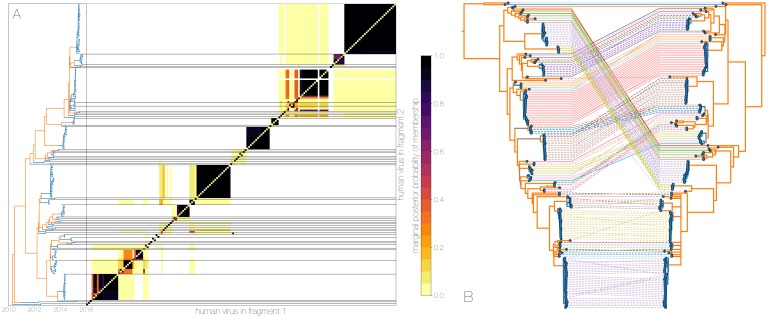
Recombinant features of MERS-CoV phylogenies.(A) Marginal posterior probabilities of taxa collected from humans belonging to the same clade in phylogenies derived from different parts of the genome. Taxa are ordered according to phylogeny of fragment 2 (genome positions 21001 to 29364) reduced to just the human tips and is displayed on the left. Human clusters are largely well-supported as monophyletic and consistent across trees of both genomic fragments. (B) Tanglegram connecting the same taxa between a phylogeny derived from fragment 1 (left, genome positions 1 to 21000) and fragment 2 (right, genome positions 21001 to 29364), reduced to just the human tips and branches with posterior probability <0.1 collapsed. Human clusters exhibit limited diversity and corresponding low levels of incongruence within an introduction cluster.10.7554/eLife.31257.027Figure 4—source data 1.XML to run structured coalescent analysis on bisected alignment with output files.10.7554/eLife.31257.028Figure 4—source data 2.Output from PHI and 3Seq recombination analyses.10.7554/eLife.31257.029Figure 4—source data 3.Output from ClonalFrameML analysis.